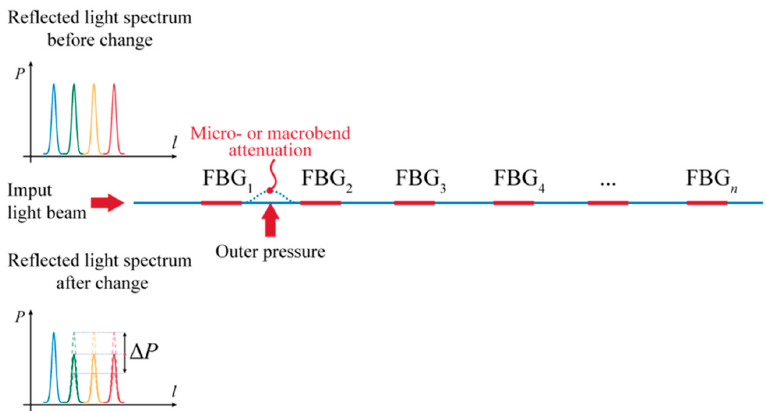
Figure 5. Principal representation of a directly distributed optical fiber sensor and its functioning.